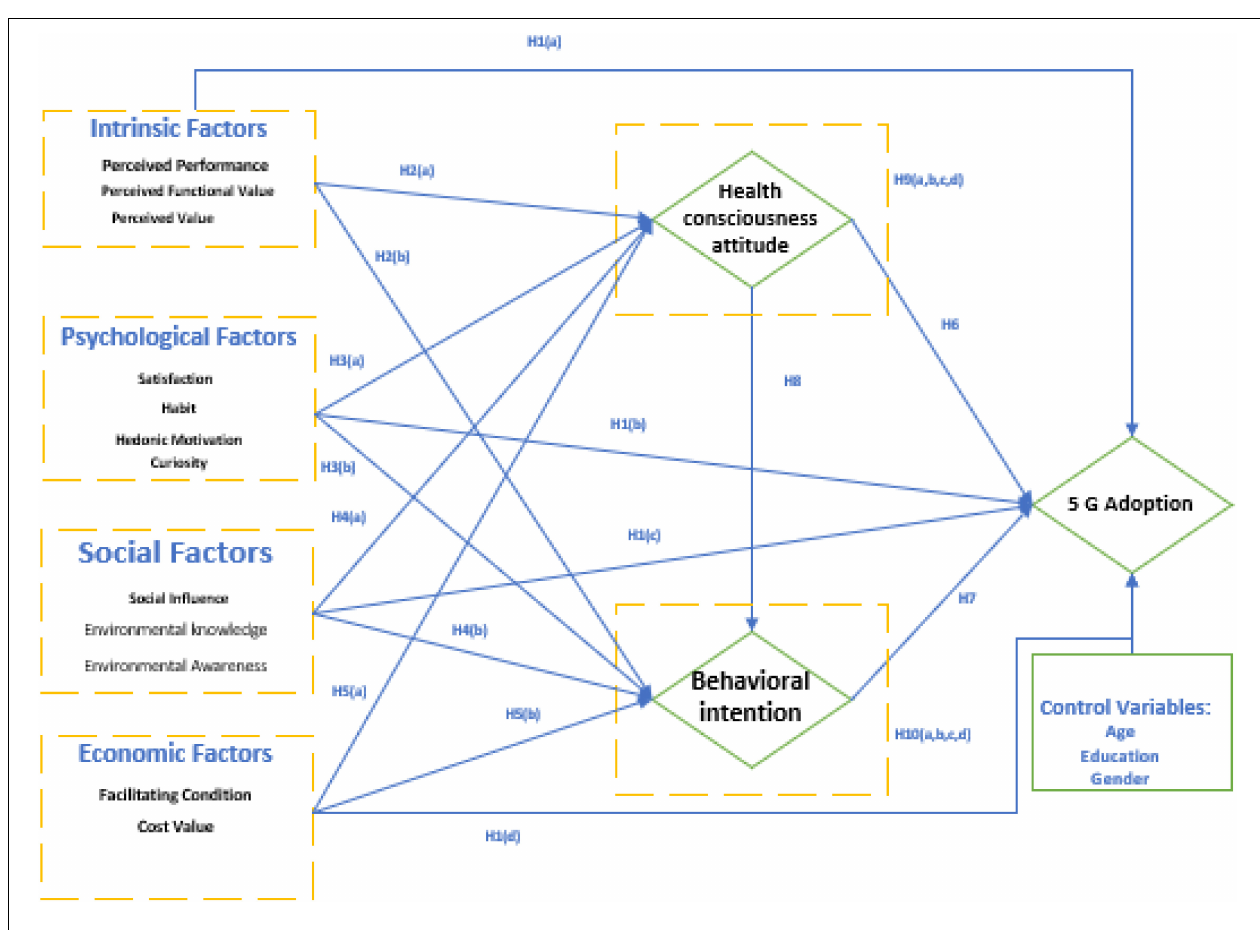
FIGURE 1 | Conceptual